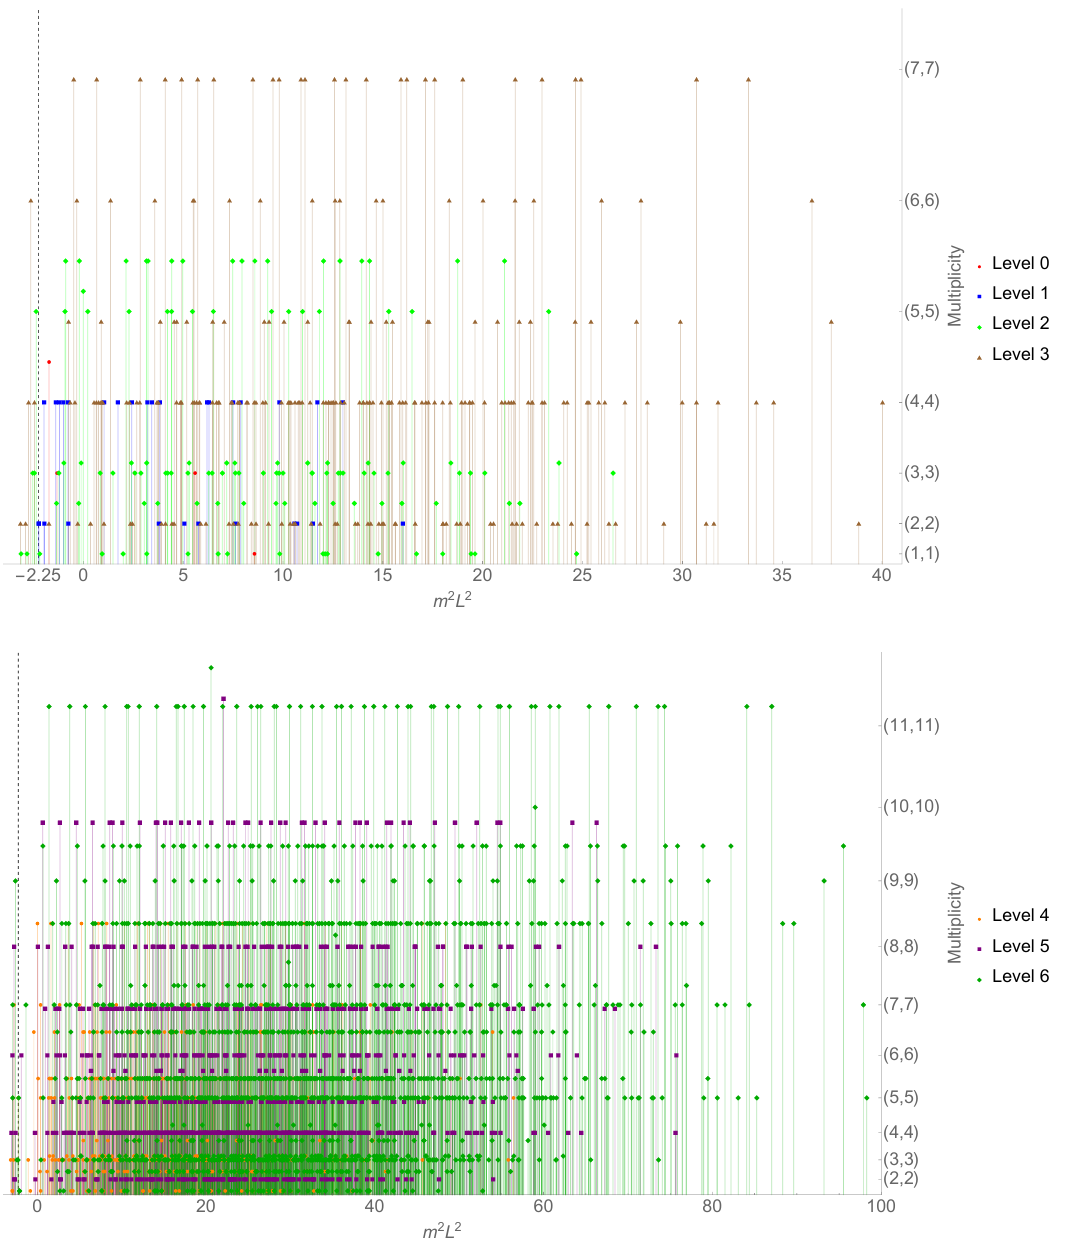
Figure 1 . Spectrum of scalar Kaluza-Klein modes, plotted as the multiplicity of Kaluza-Klein mass eigenvalues for levels 0{6. m is the mass of the Kaluza-Klein mode, L is the AdS length and the multiplicity is determined by the SO(3) (cid:2) SO(3) representation, ( k ; k ), of the mode. The dashed line denotes the BF bound m 2 L 2 = (cid:0) 2 :